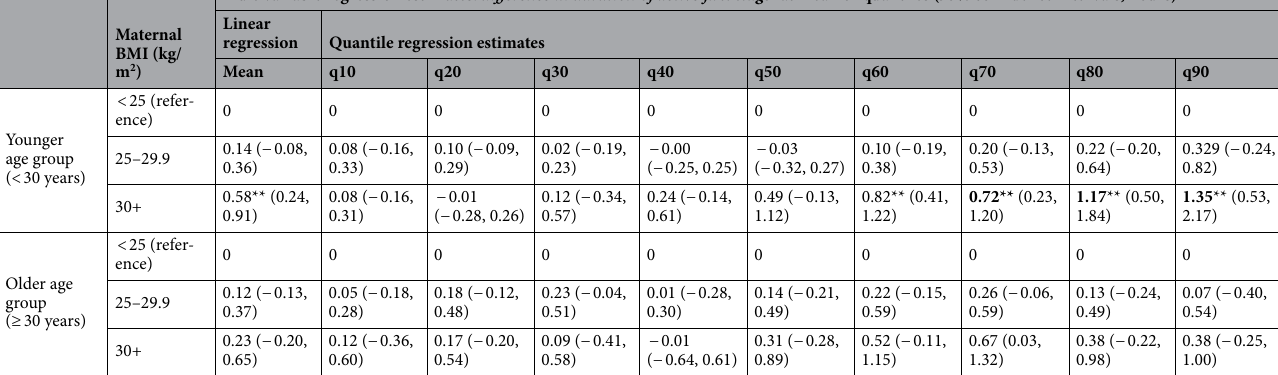
Table 4. Multivariable regression analysis for association of duration of active first stage with maternal early-pregnancy BMI, using the Stockholm-Gotland obstetric database, 2008–2014. Multivariable regression analysis on two age sub-groups separately: maternal early pregnancy BMI categorized into three sub-groups, with adjustment for maternal height (in restricted cubic splines with 3 degrees of freedom), smoking status (dummy variable), co-habitation status (categorical variable), year of birth (categorical variable); stratified on two separate age groups. a Duration of active first stage: the length from the start of active phase of labour until the time point of the cervix fully dilated. **p-value <